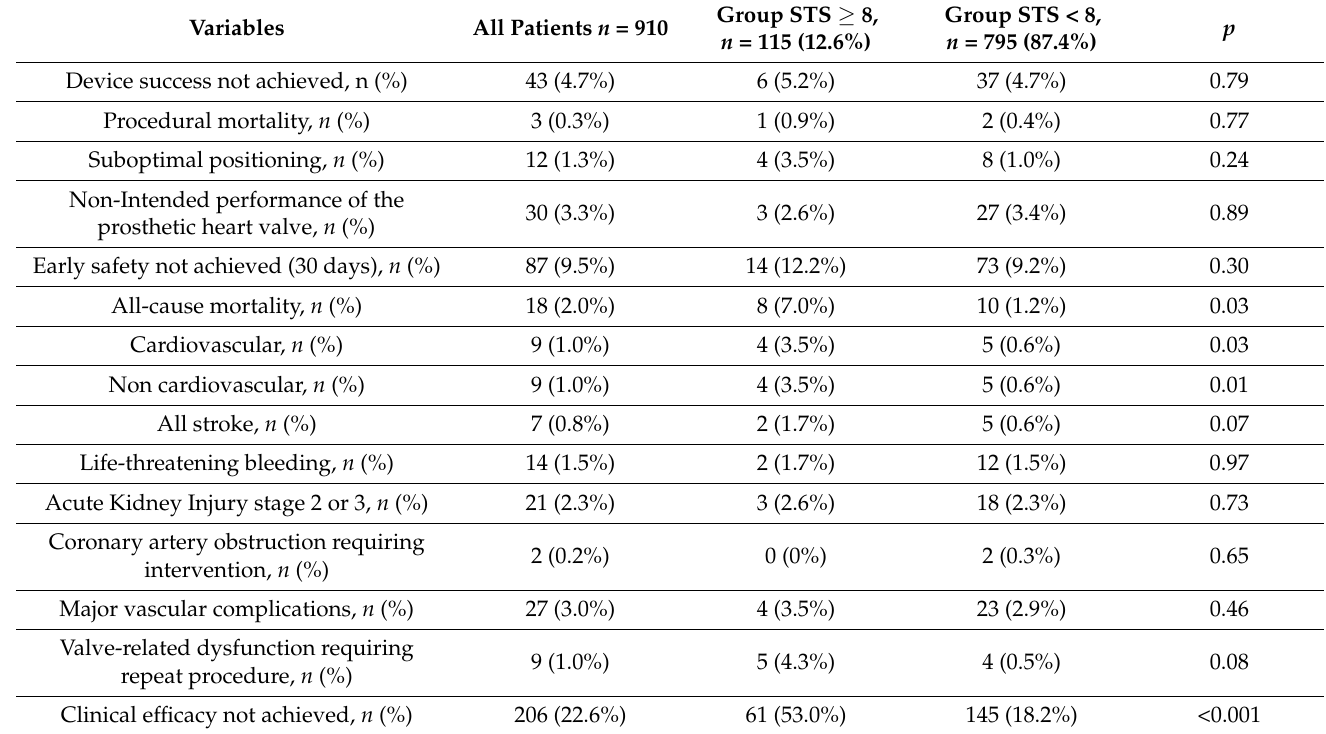
Table 2. Thirty-day adverse events according to